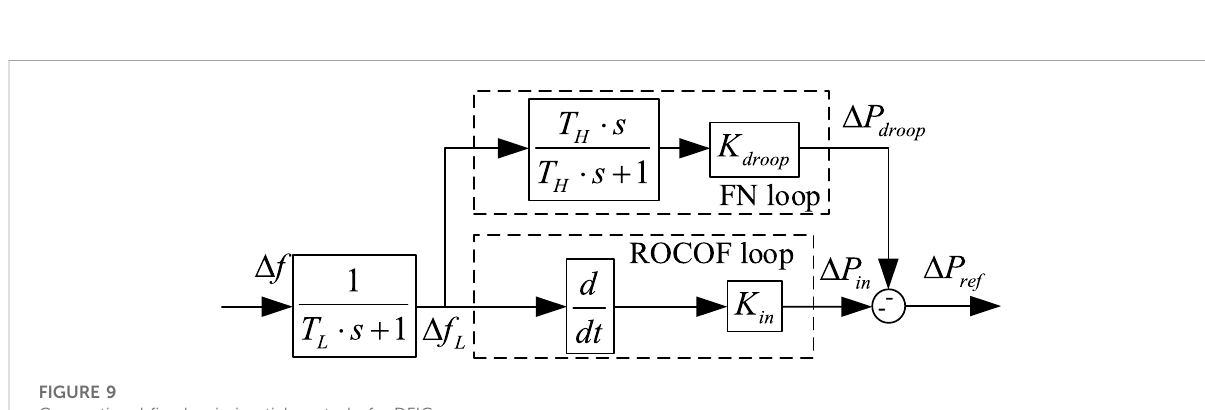
FIGURE 9 Conventional fi xed-gain inertial control of a